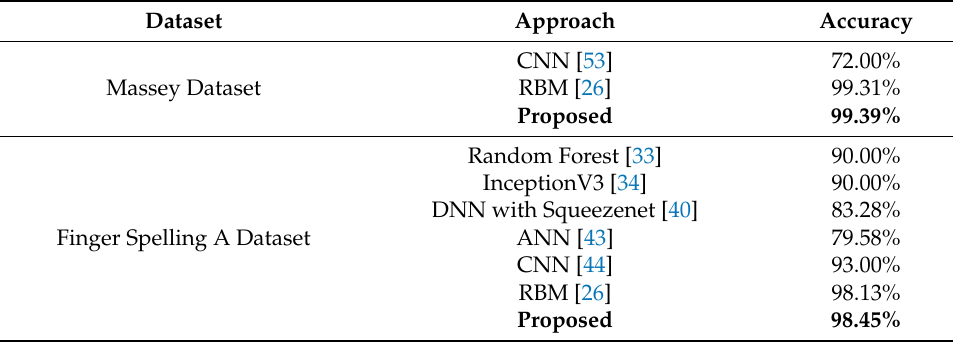
Table 10. Comparison with other existing